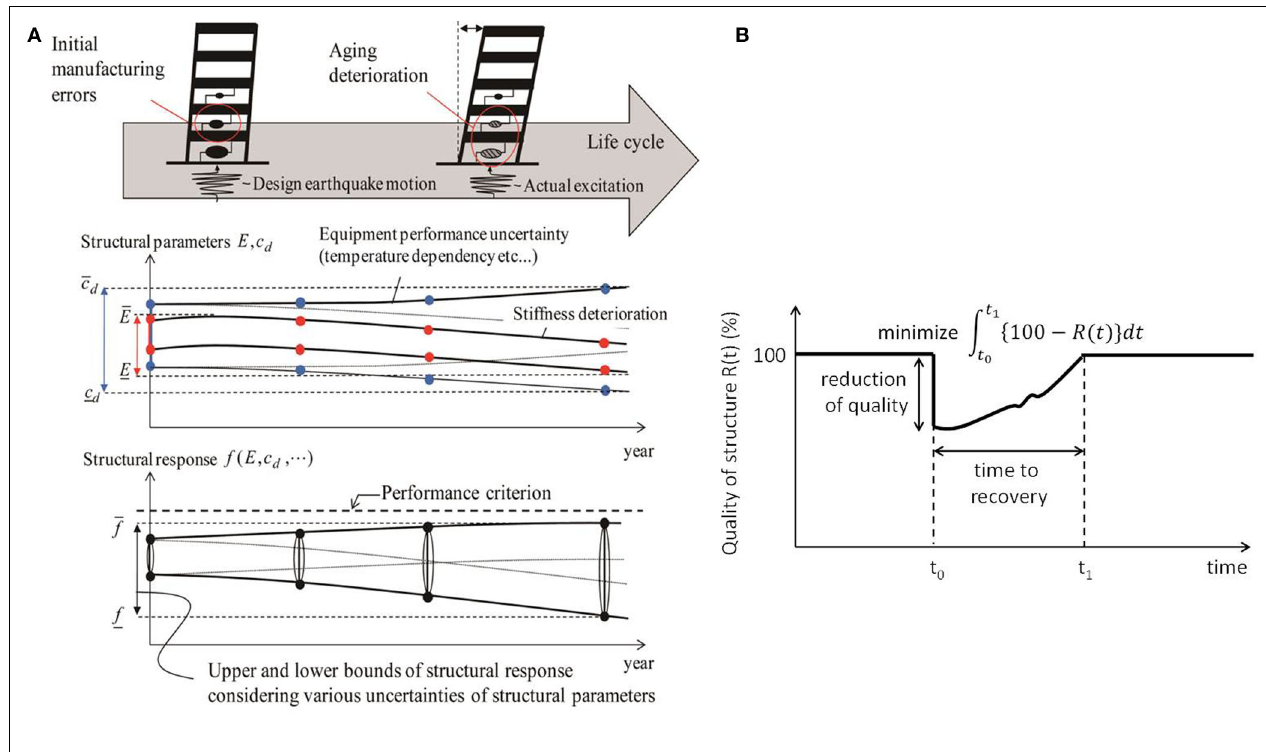
FIGURE 2 | (A) Sustainable design concept considering varied structural performance caused by various uncertainties of structural parameters (Fujita and Takewaki, 2011b), (B) example of earthquake resilience